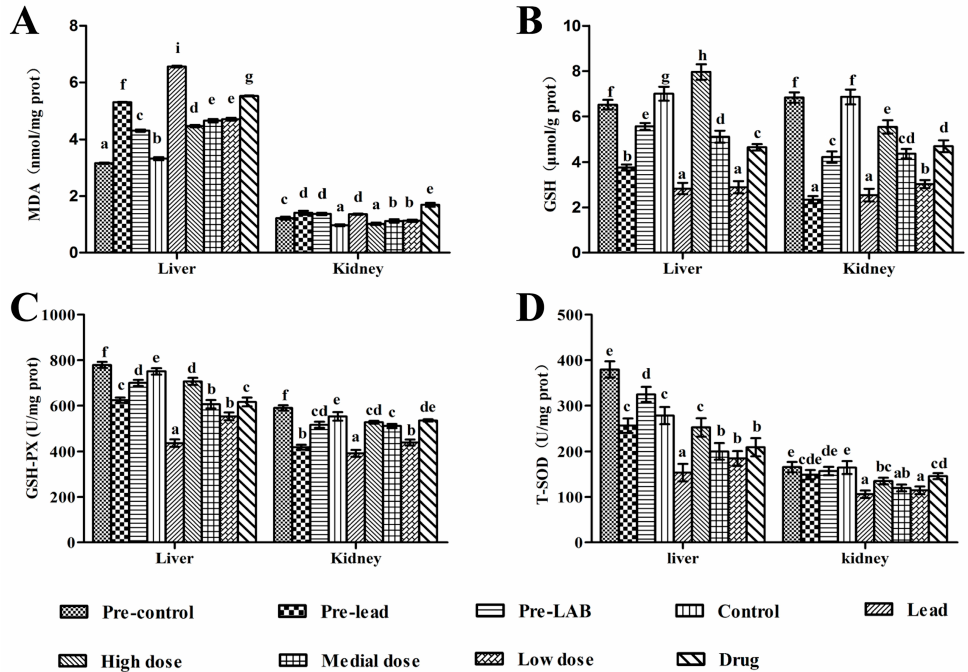
Figure 6. Effects of L. bulgaricus KLDS1.0207 on Pb-induced variations of antioxidant capacity in the liver and kidney of mice: ( A ): Malondialdehyde (MDA); ( B ): Glutathione (GSH); ( C ): Glutathione peroxidase (GSH-PX); and ( D ): Total superoxide dismutase (T-SOD). Values are mean ± SD. Significant differences ( p < 0.05) among the groups are indicated with different letters above the graphical bars.